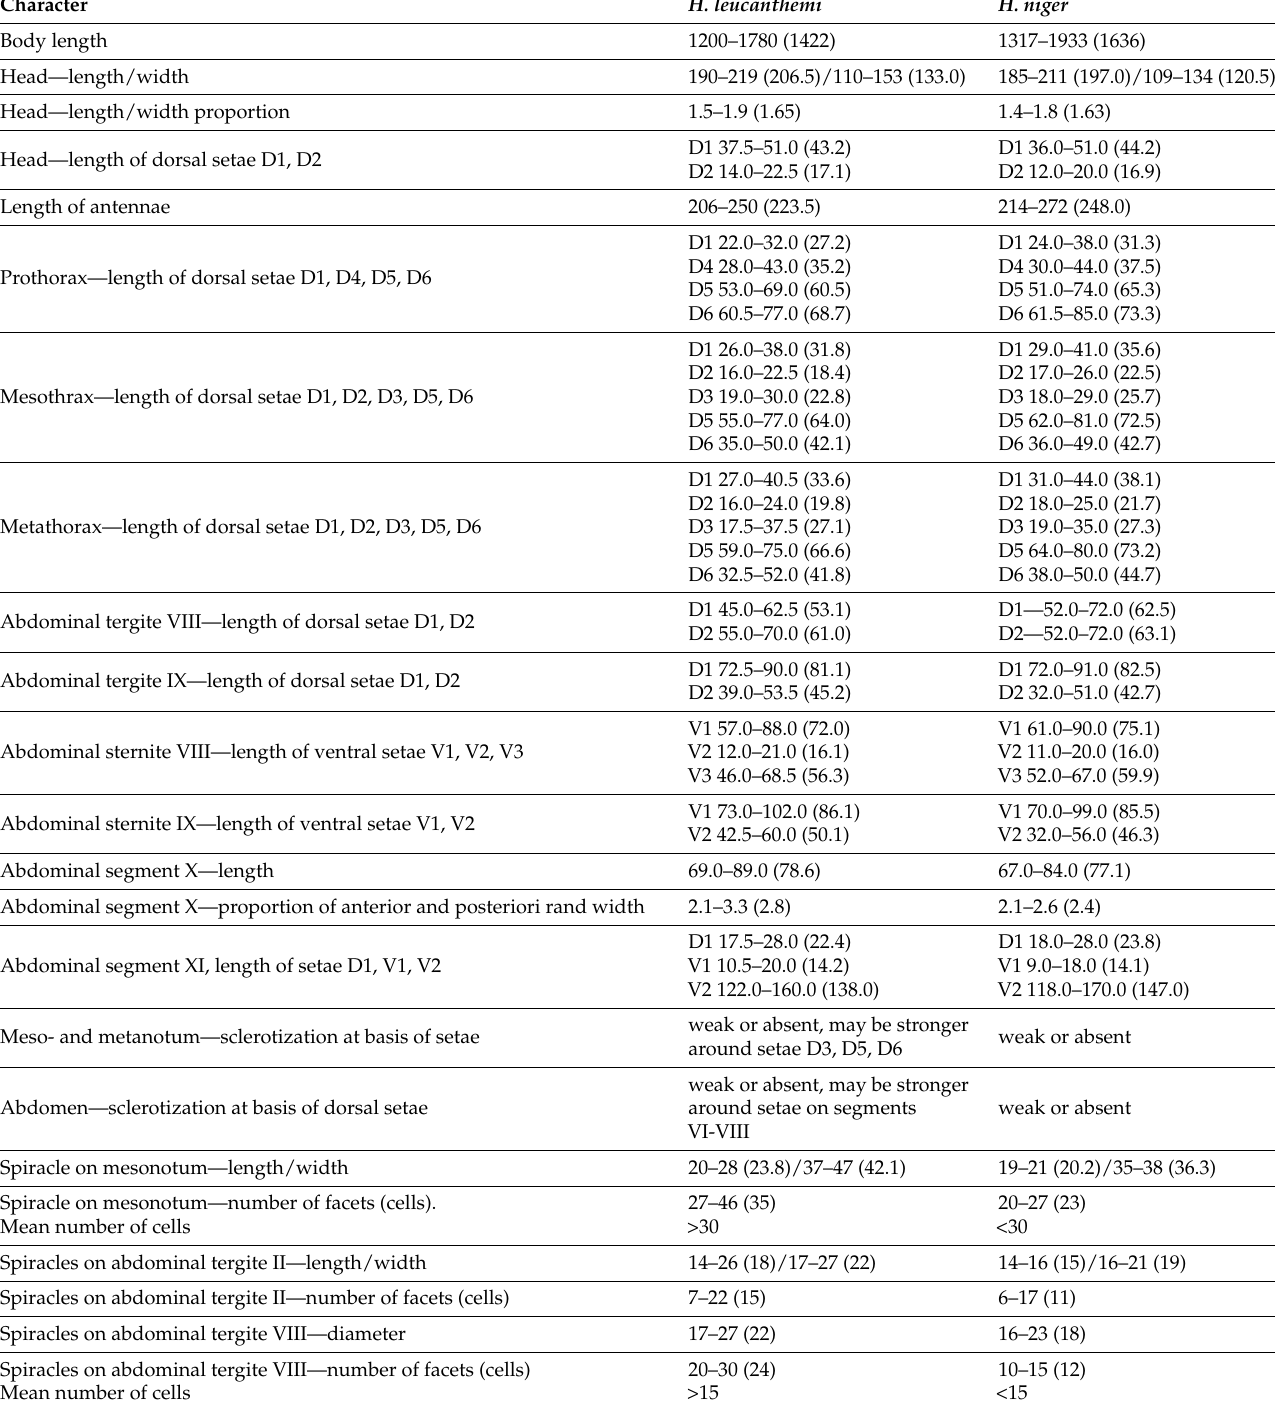
Table A2. Character states used in morphological analyses of Haplothrips leucanthemi and H. niger second larval instar with the range of obtained measurements. Values are given in µ m. The mean or the modal values (number of facets) are given in